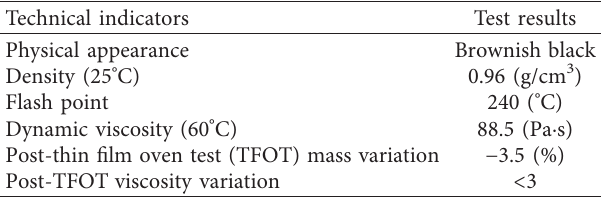
Table 1: Bioasphalt technical indicators.